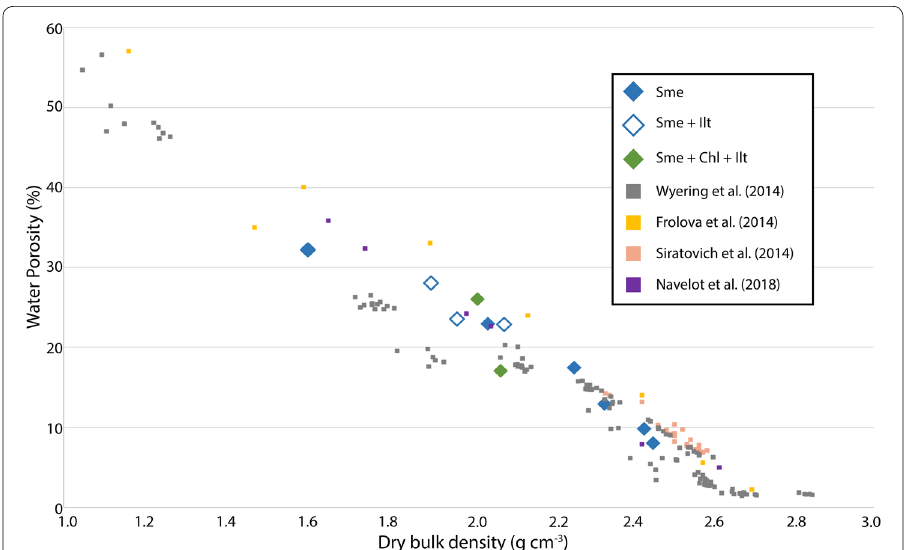
Fig. 9 Graph representing the water porosity (triple weighing) versus bulk density, comparing data of this study differentiated by their specific clay assemblage with data from Taupo Volcanic Zone (New-Zealand, Siratovich et al. 2014; Wyering et al. 2014), Kuril-Kamchatka island (Russia, Frolova et al. 2014) and Guadeloupe (Navelot et al.